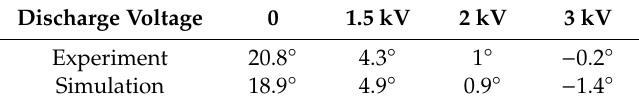
Table 1. Simulation and